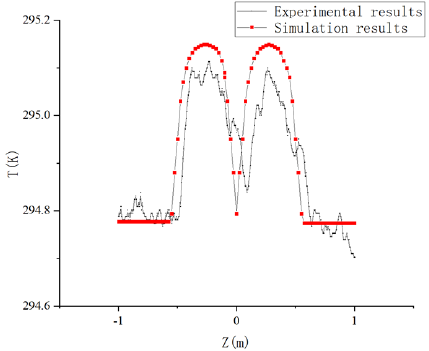
Figure 10. Temperature comparison at straight AB.